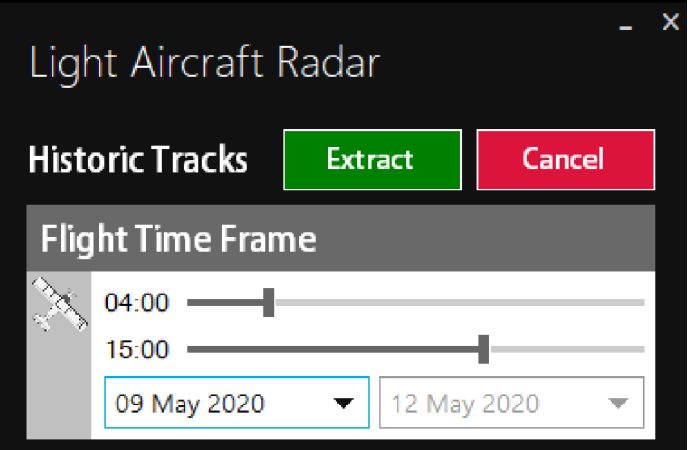
Figure 12. Design for the historical data